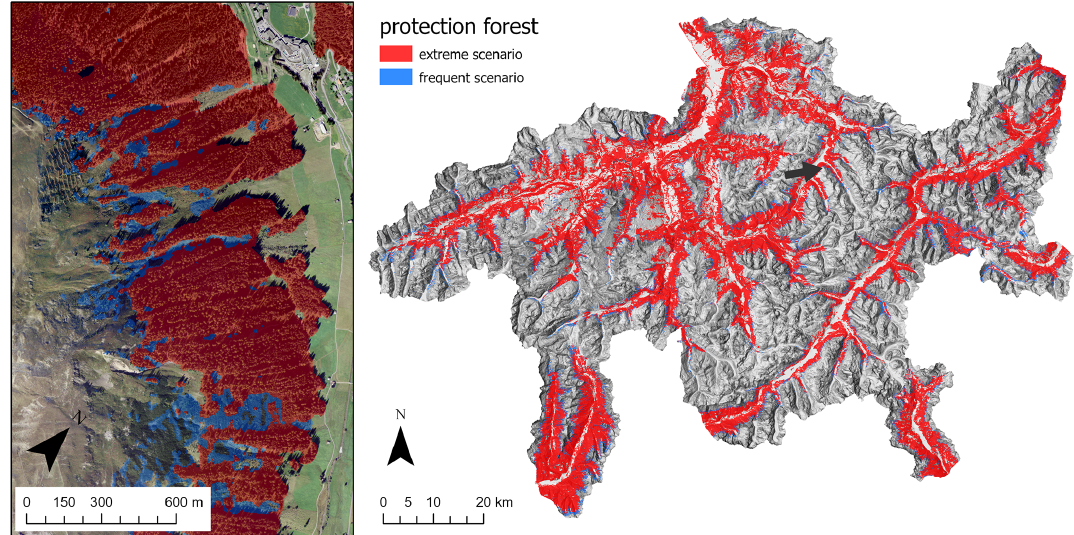
Figure 4. Protection forest map for the canton of Graubünden for a frequent (10–30 years) avalanche scenario (corresponding to avalanche events with a 10–30-year return period, displayed in blue and red combined) and for an extreme-snow-cover scenario (corresponding to a ca. 100–300-year avalanche event, displayed in red). Orthophoto source: Swiss Federal Office of